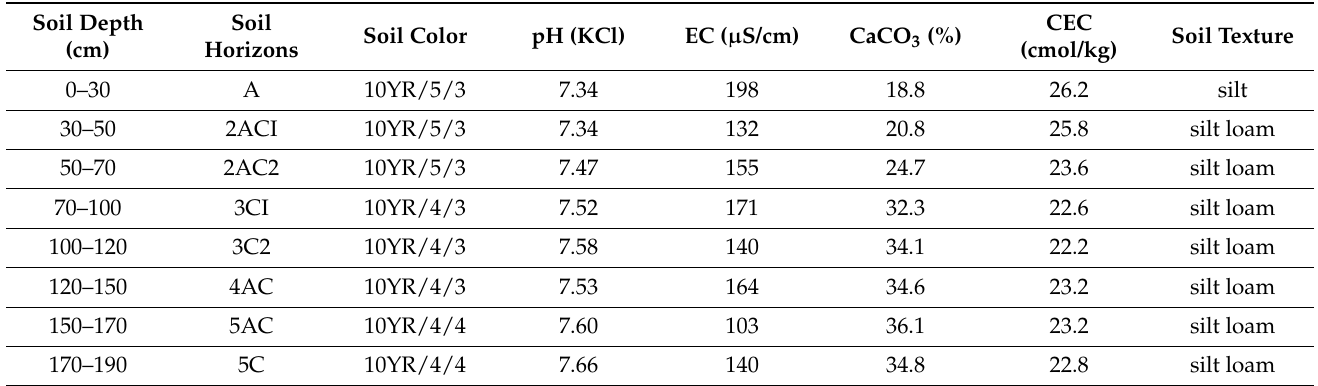
Table 1. Physical and chemical characteristics of analyzed soils.